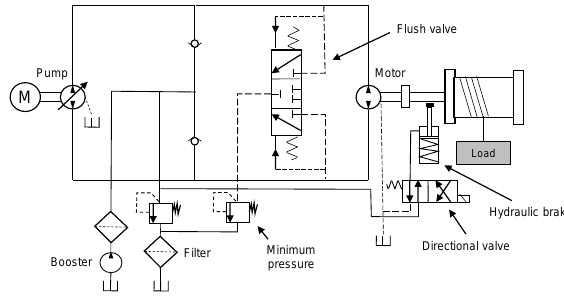
Figure 3: Schematic of a primary controlled closed- circuit hydraulic